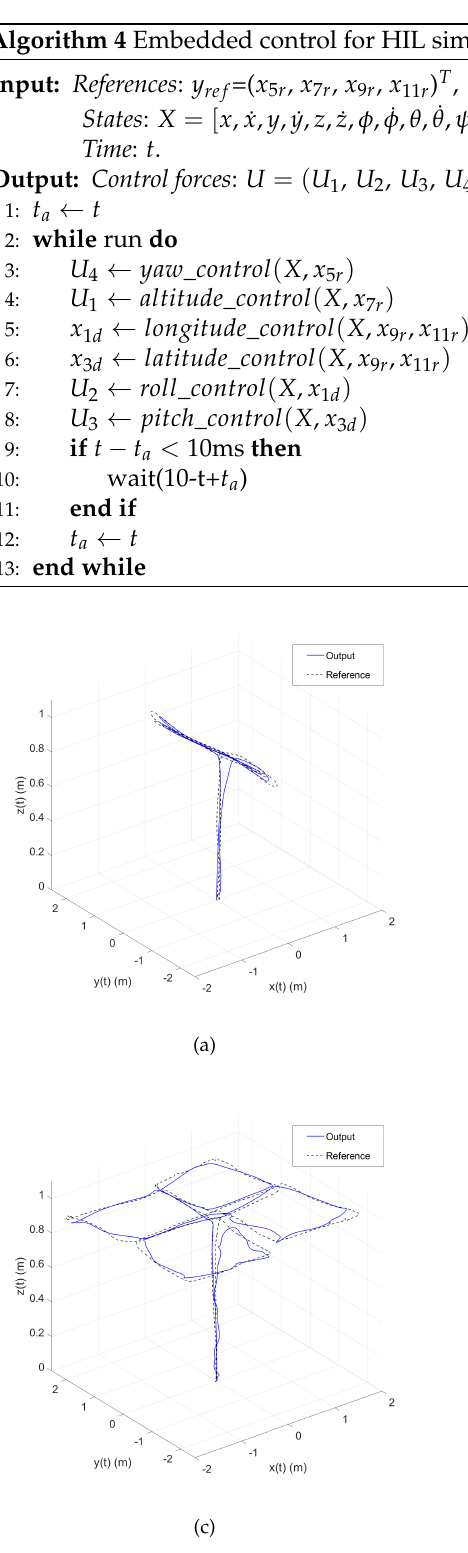
Figure 14. Drone’s absolute position obtained with the HIL simulation in Simulink. ( a ) First move- ment trajectory tracking with the HIL simulated model. ( b ) Second movement trajectory tracking with the HIL simulated model. ( c ) Third movement trajectory tracking with the HIL simulated